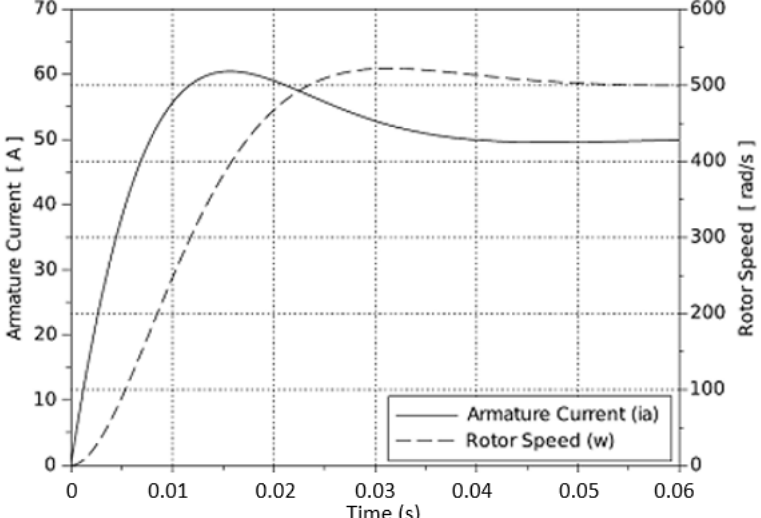
Figure 8. A simulation using Scilab of the armature current i a ( t ) and rotor speed ω ( t ) under no-load conditions when using a constant supply voltage of v s = 100